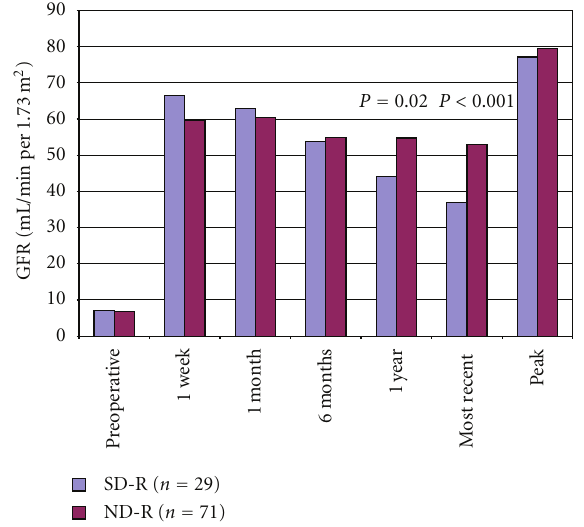
Figure 3: Comparison of calculated glomerular filtration rates in mL/min per 1.73m 2 between recipients of renal allografts from living donors who have a history of tobacco use (SD-R) and donors with no history of tobacco use (ND-R).